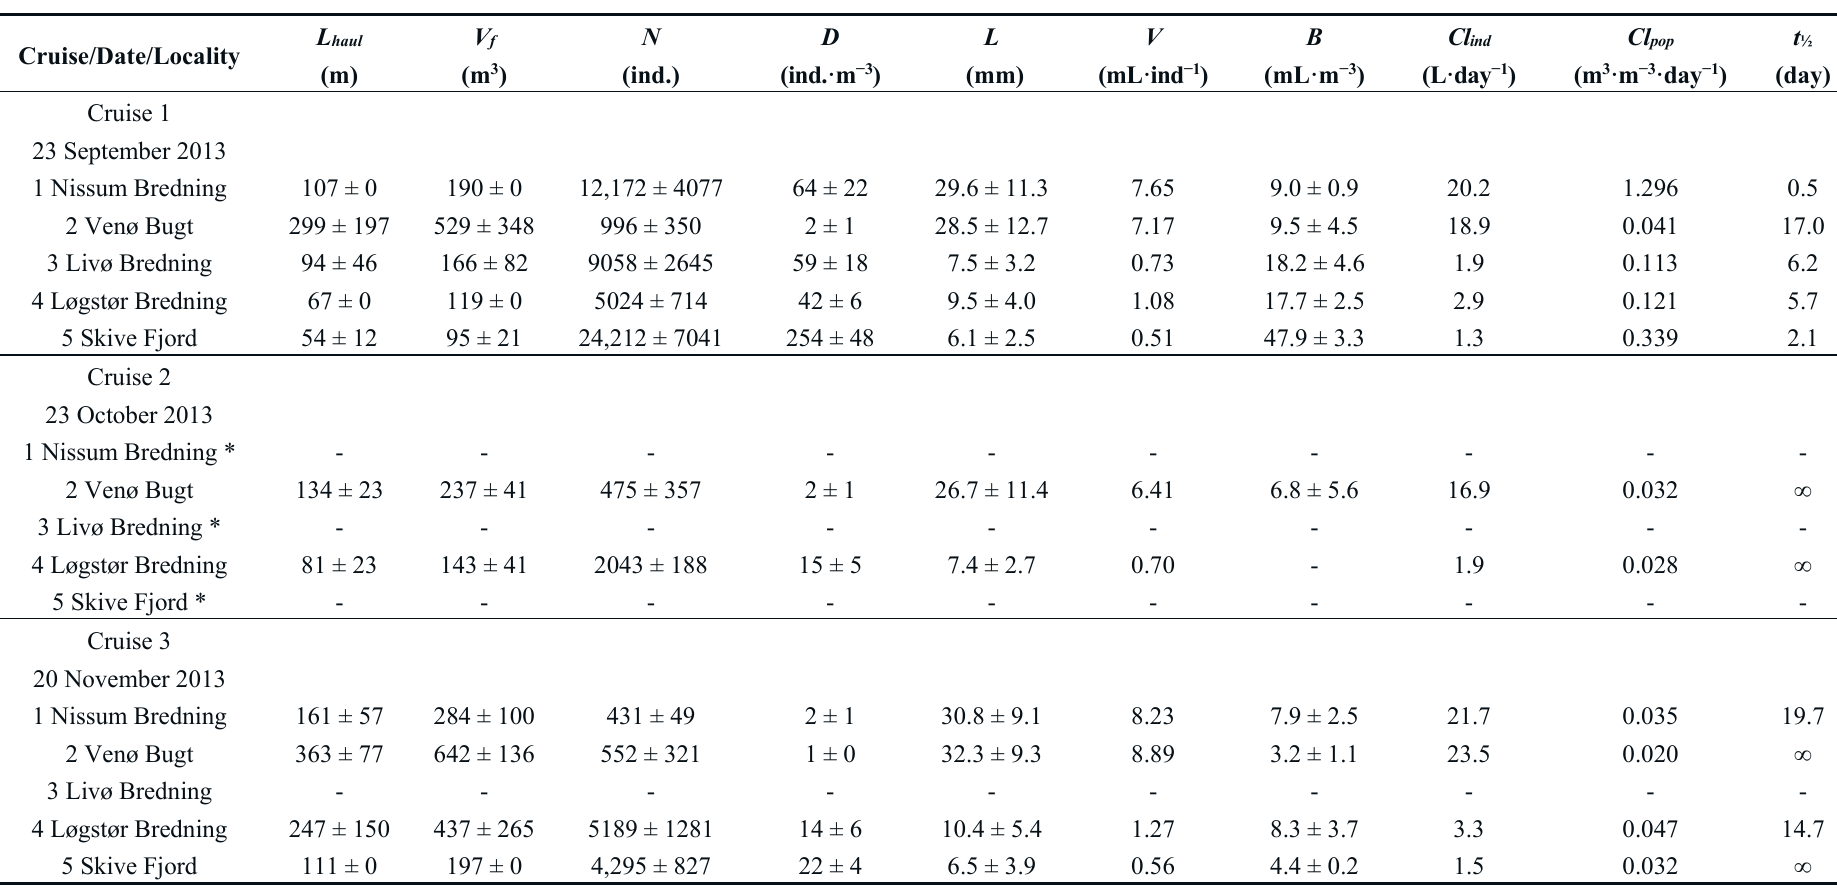
Table 4. Mnemiopsis leidyi collected during three cruises in Limfjorden in 2013. L haul = haul length; V f = volume filtered per haul; N = total number of individuals caught; D = population density; L = oral–aboral body length; V = estimated individual body volume (Equation (3)); B = measured total bio-volume of ctenophore population; Cl ind = individual clearance rate (Equation (4)); Cl pop = population clearance rate (Equation (5)); t 1 / 2 = estimated half-life of copepods (Equation (6); t 1 / 2 > 3 weeks are indicated by ∞ ). Mean ± SD are